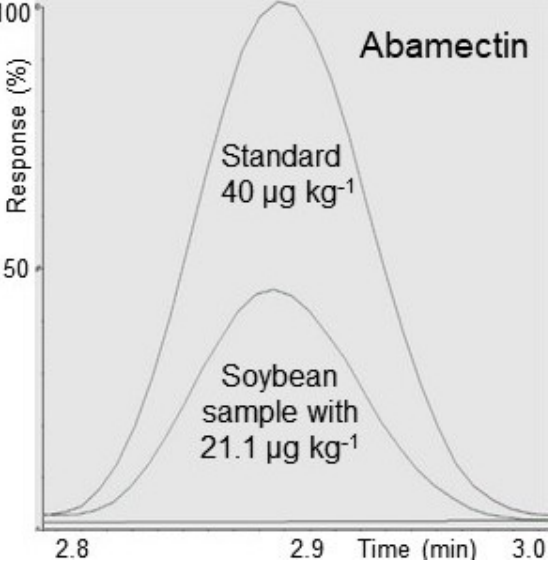
Figure 2. Overlapping of the signal obtained from a positive sample of soybean for abamectin (21.1 μ g kg − 1 ) and a standard in blank matrix corresponding to 40 μ g kg − 1